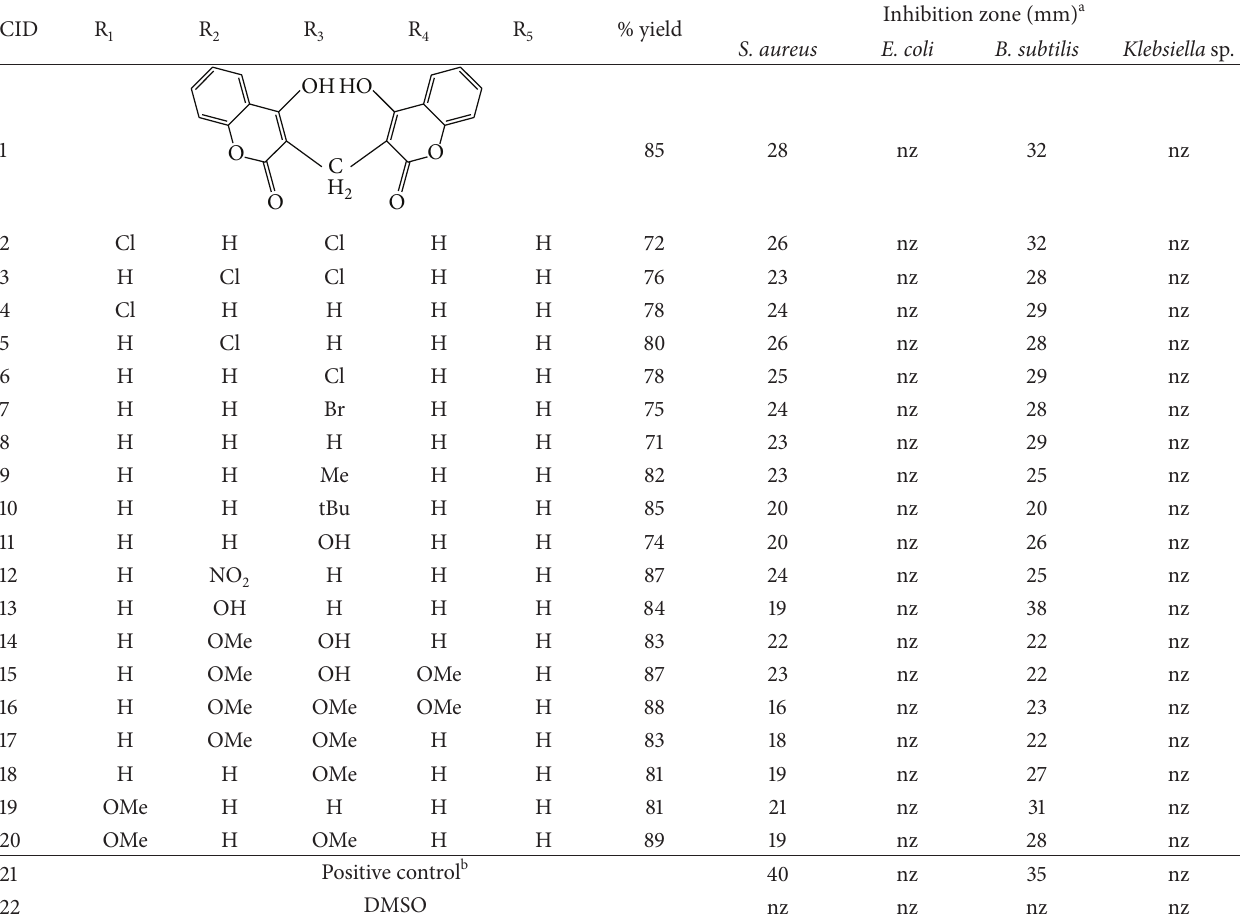
Table 1: Reaction yield and antibacterial properties of dicoumarols.